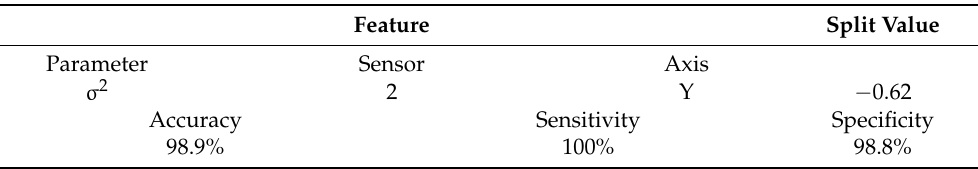
Table 5. Split Values, Accuracy, Sensitivity and Specificity for Prone-Rocking Decision Tree calculated according to [43].